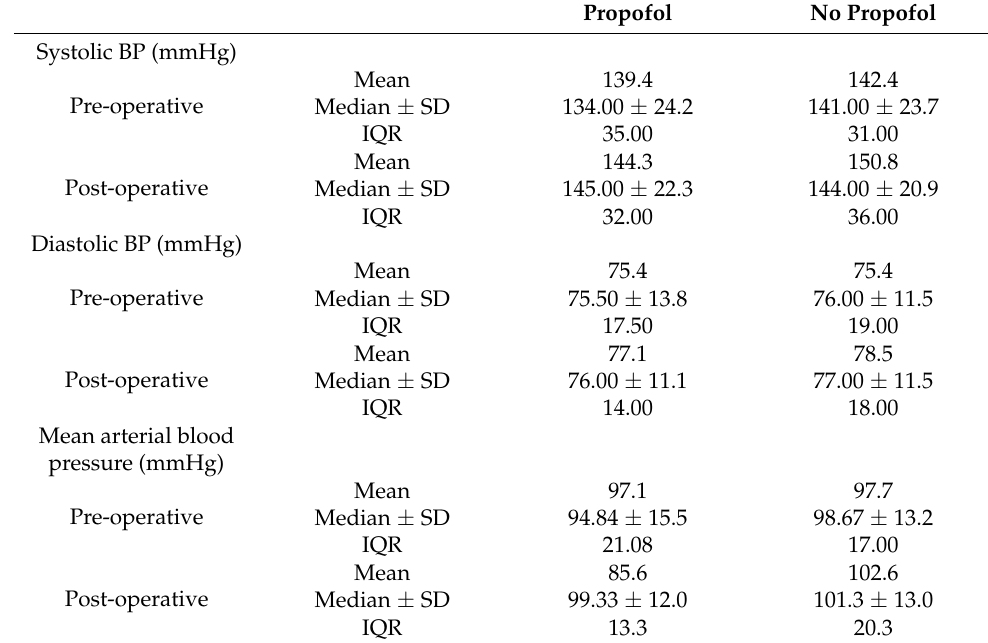
Table 2. Comparative summary of the blood pressure results of both patient